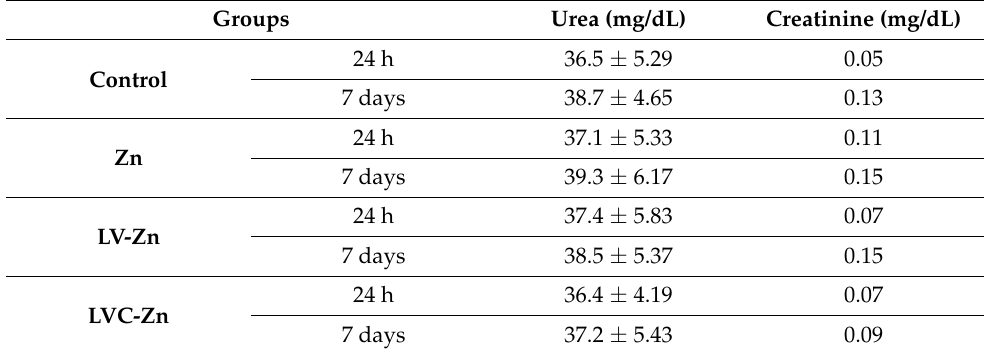
Table 3. The influence of LV-Zn and LVC-Zn on the serum urea and creatinine concentrations. Values were expressed as mean ± S.D. of mean for 6 rats in a group.